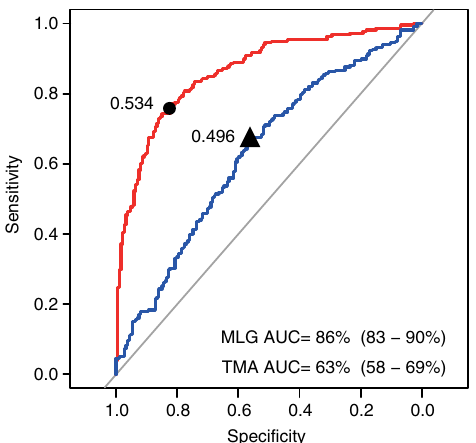
Fig. 3 Gut microbiome-based identi fi cation of ACVD. Receiver operating curve (ROC, red ) according to cross-validated random forest models on MLGs ( fi vefold RFCV performed fi ve times) from stool samples of 218 ACVD and 187 healthy individuals. The 47 MLGs selected are shown in Supplementary Fig. 5 and Supplementary Data 3. The 95% con fi dence intervals (CIs) of the AUCs are shown in parentheses. The blue line indicates ROC based on TMA lyases (CutC/D, YeaW/X), with its corresponding ACVD probability shown in Supplementary Data 8 and Supplementary Table 3. The best cutoff points were marked on the ROCs